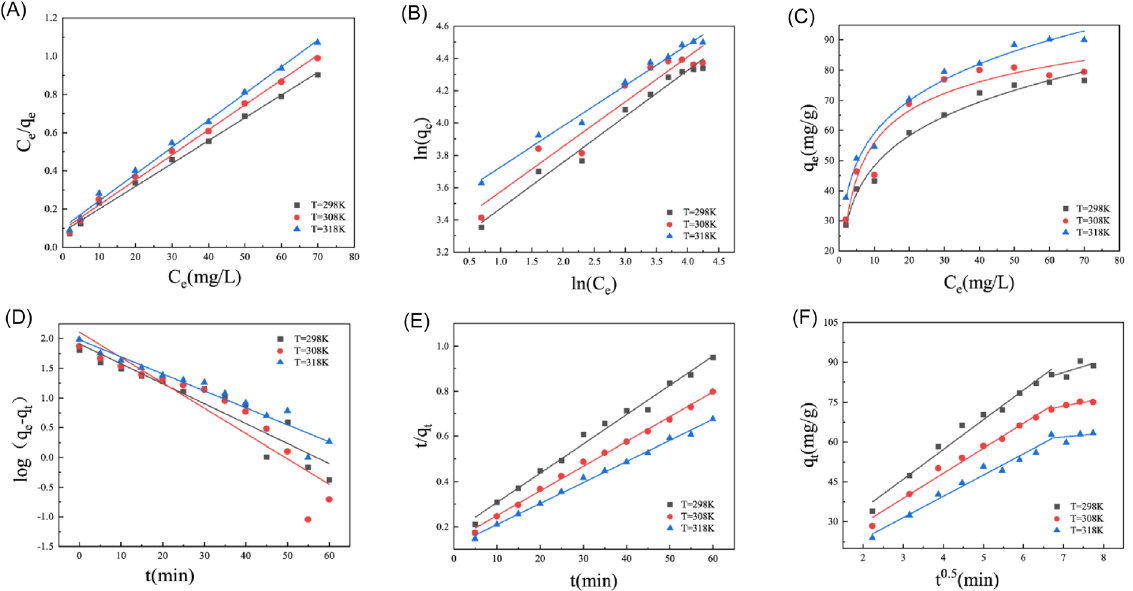
Fig. 5 The adsorption model for chromium (VI) Langmuir model ( A ) Freundlich model ( B ) Redlich Peterson ( C ) and the adsorption kinetic model for chromium (VI) Pseudo-first-order kinetic ( D ) Pseudo-second-order kinetic ( E ) Webber–Morris kinetic ( F )